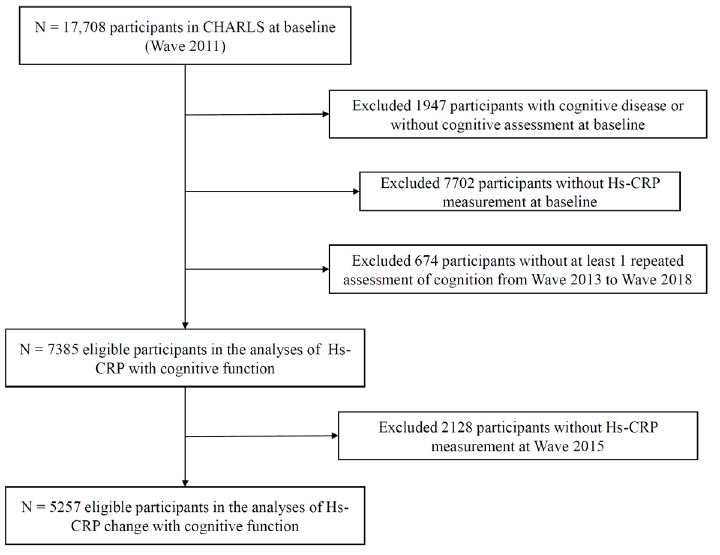
Figure 1. Flow chart of participants ’ inclusion.